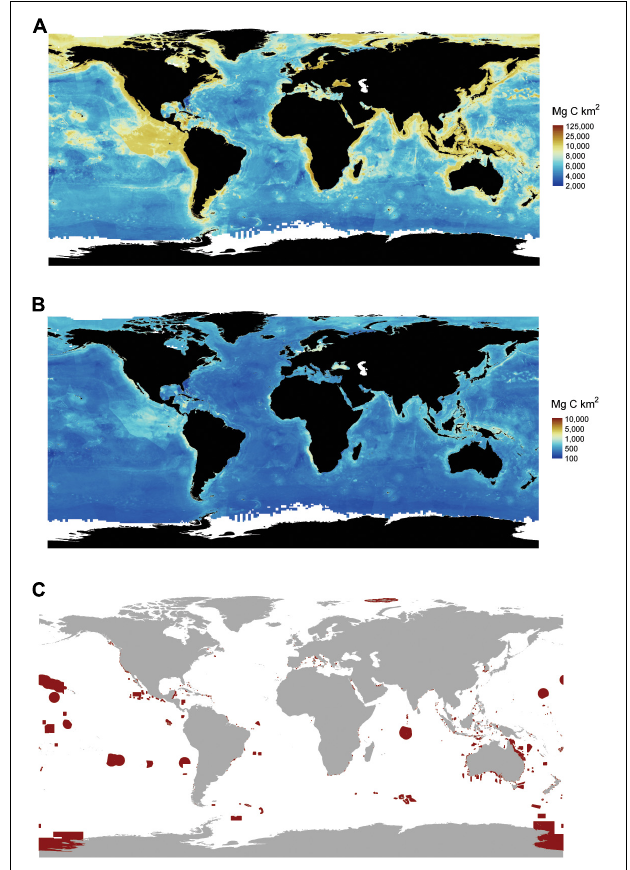
FIGURE 6 | Global marine sediment carbon (C) stocks and marine protected areas. (A) Average distribution of global marine sediment C stocks. Stocks represent the amount of C stored in the top 1 m of sediment. (B) Uncertainty in C stocks as express by the difference between the upper and lower 95% CI. (C) Locations of marine protected areas. Areas circled in red are implemented fully to highly protected marine areas where only light extractive activities are allowed, and other impacts are minimized to the extent possible. Data on marine protected areas are from http://mpatlas.org/map/mpas/ (Marine Conservation Institute, 2019). MPAtlas. Seattle, WA, United States. www.mpatlas.org [Accessed